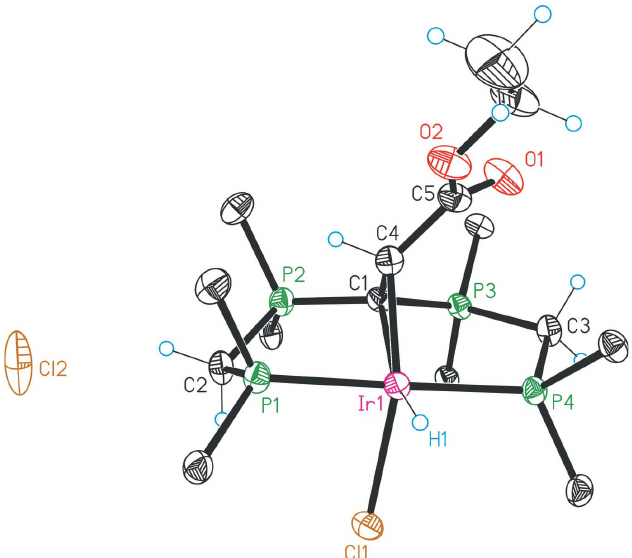
Figure 2 Molecular structure of the complex cation in 4 and the counter-anion. Displacement ellipsoids are drawn at the 30% probability level. For clarity, only the ipso carbon atoms of the phenyl groups are presented and the solvent molecules are